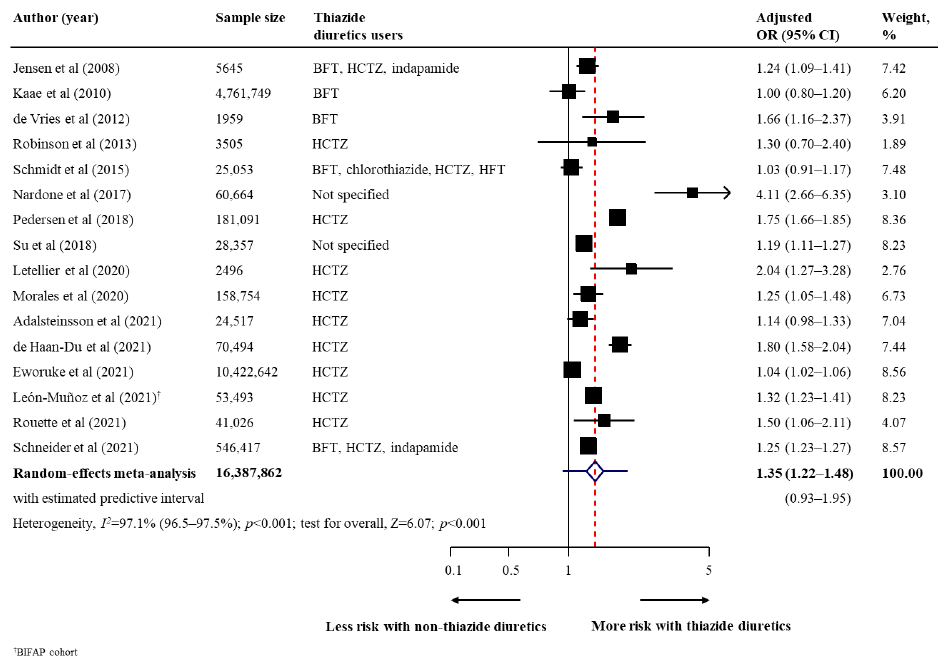
Figure 3. Effect of the use of thiazide diuretics and the risk of squamous cell carcinoma. Abbreviations: BFT, bendroflumethiazide; CI, confidence interval; HCTZ, hydrochlorothiazide; HFT, hydroflumethiazide; OR, odds ratio [30,31,33,36–38,40,42,47,48,50,51,53,56–58].